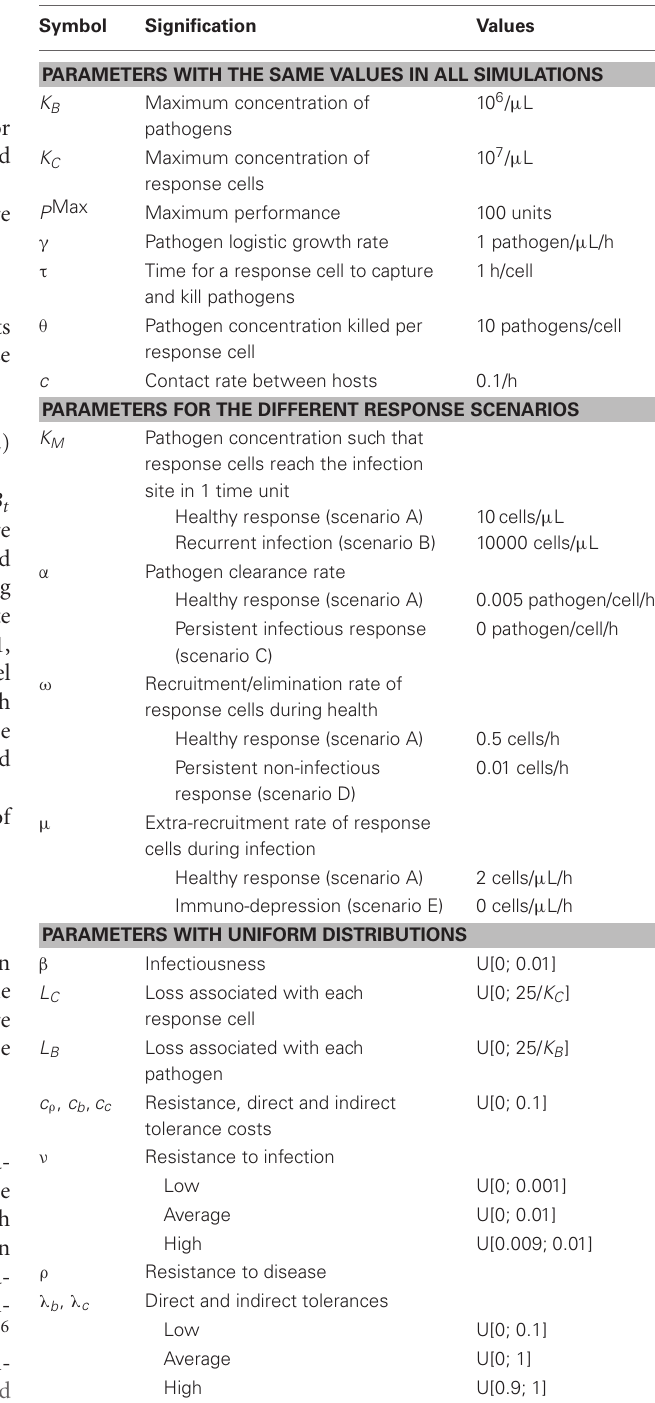
Table 1 | Symbol, signification and values of the